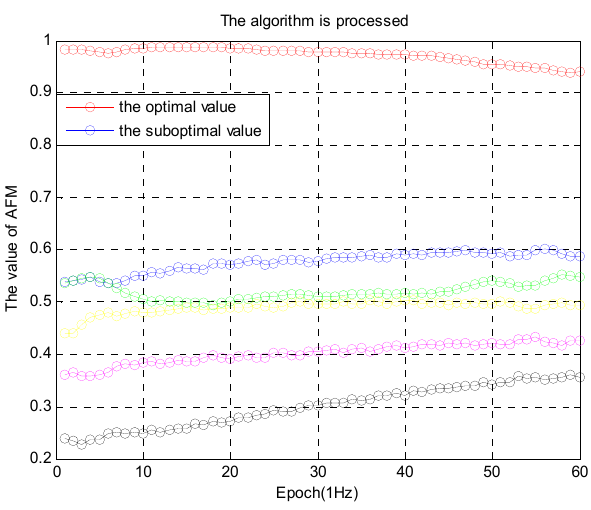
Figure 9. Algorithm after processing.